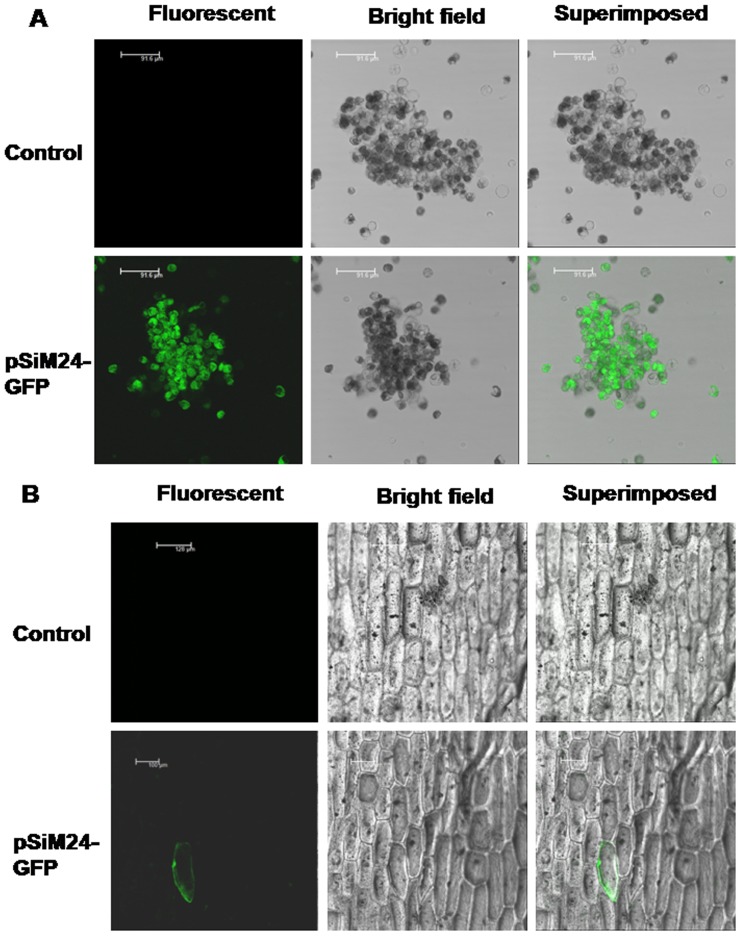
Transient expression of pSiM24-GFP in tobacco protoplasts and onion epidermal cells.(A) Protoplasts were transfected with plasmids pSiM24 (Control) and pSiM24-GFP (having GFP reporter gene). Transformation efficiencies were determined by analyzing the protoplasts with fluorescence after incubation for overnight. Fluorescent, bright-field and superimposed (bright-field and green fluorescent) confocal laser scanning micrographs of tobacco protoplasts are presented. Scale bar, 92 µm. (B) Fluorescent, bright-field and superimposed (bright-field and green fluorescent) confocal laser scanning micrographs of onion epidermal cells bombarded with pSiM24-GFP construct DNA-loaded gold particles are presented. Control represents onion epidermal cells with pSiM24 visualized under CLSM. Scale bar, 100 µm.